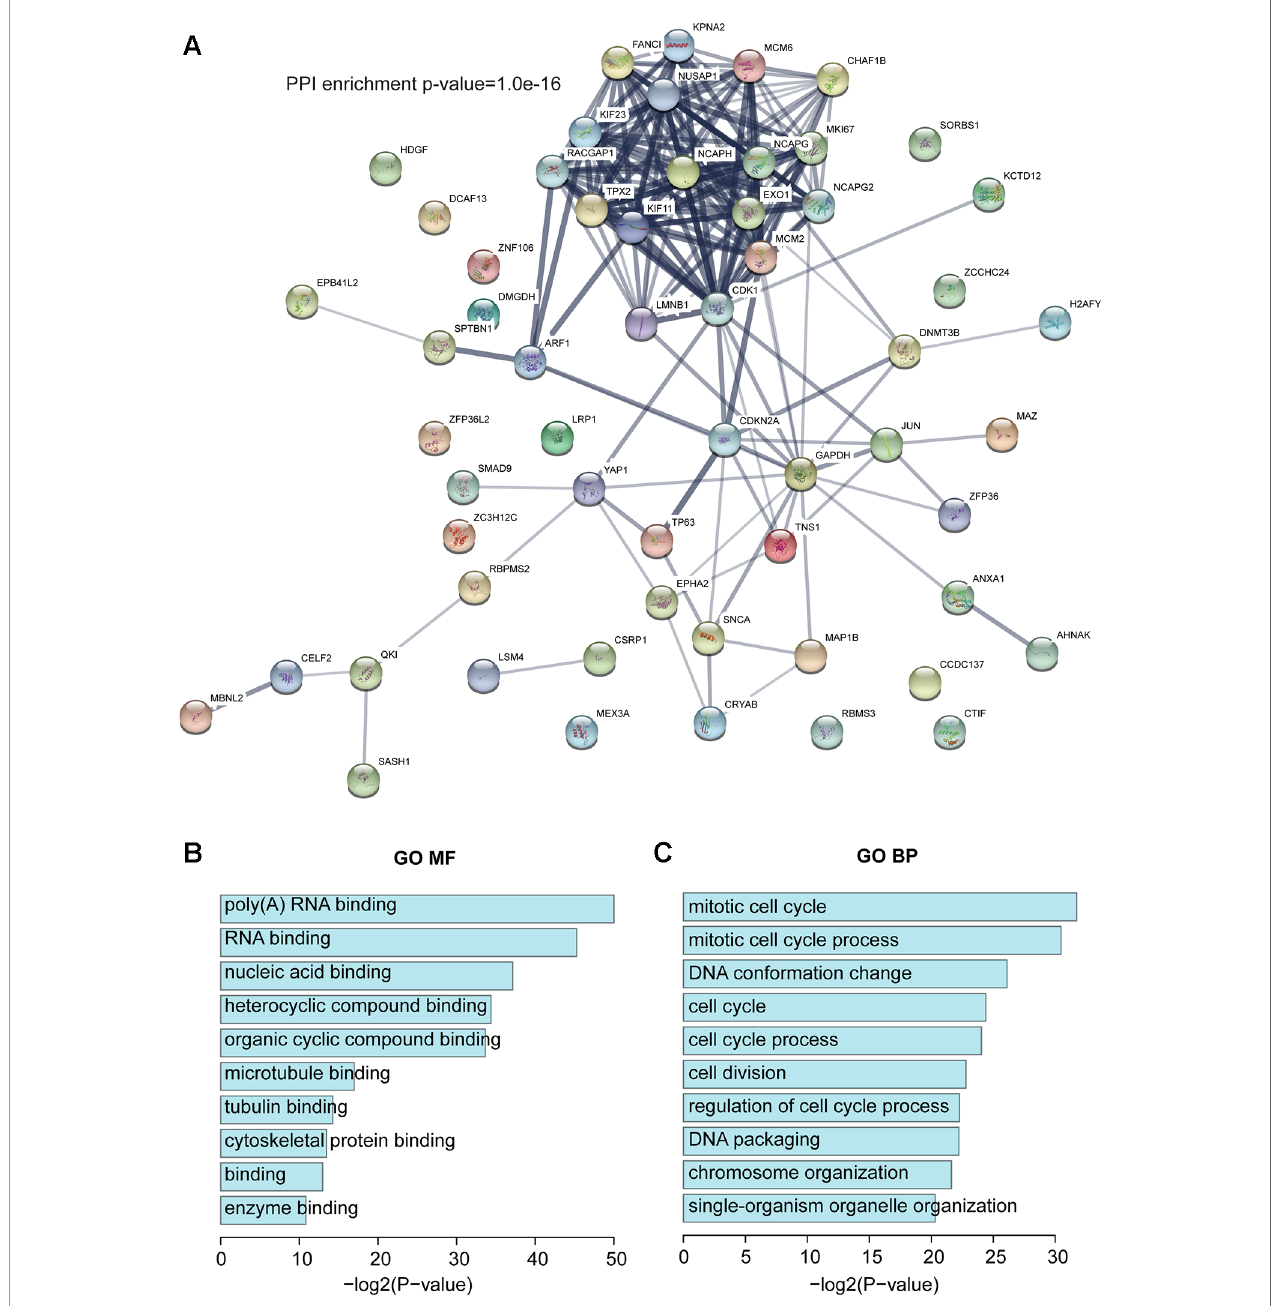
FIGURE 3 | RBPs in the dysregulated network. (A) Protein – protein interaction (PPI) network of RBPs based on STRING. (B) The top 10 enriched GO MF terms. (C) The top 10 enriched GO BP terms. BP, biological